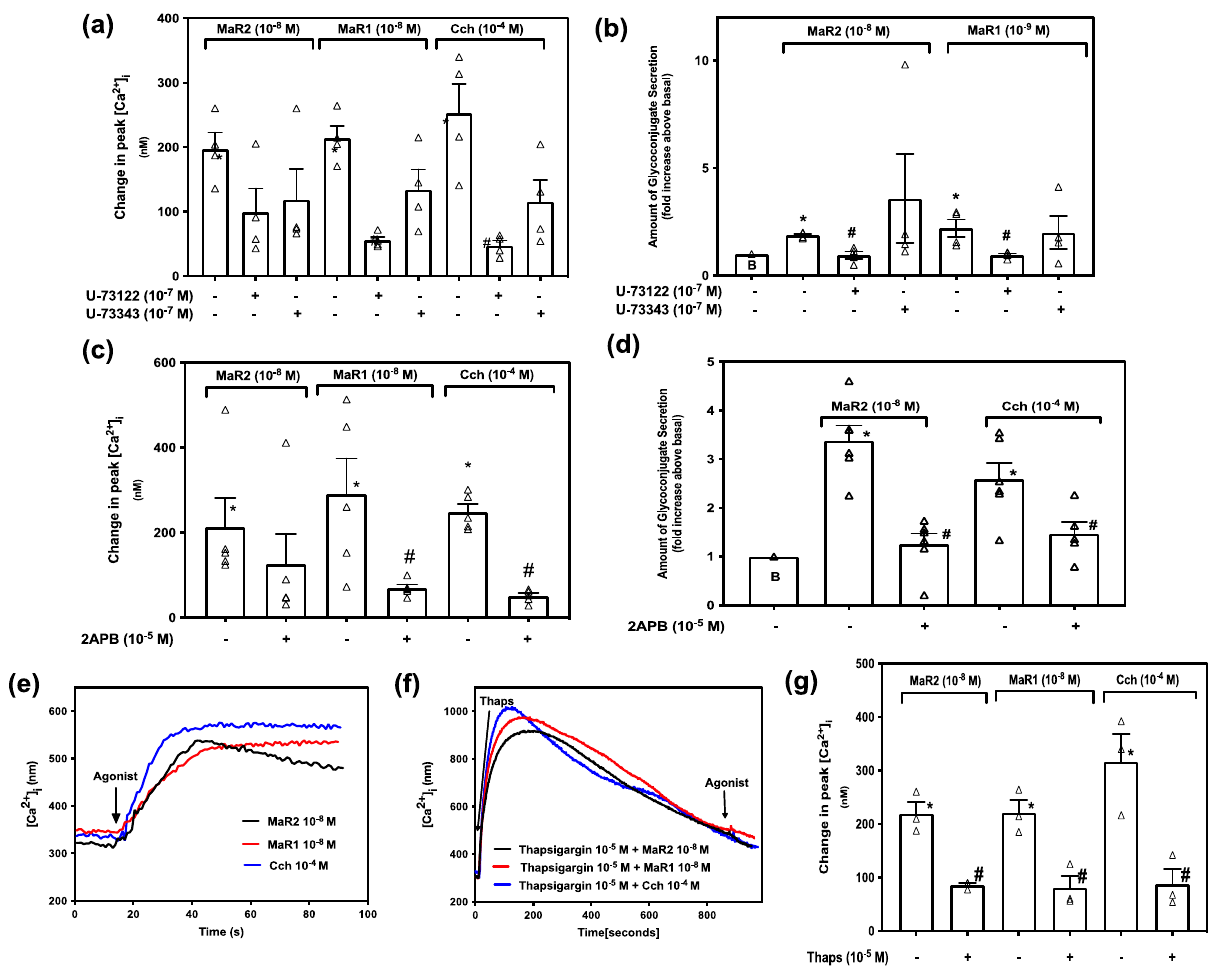
Figure 5. Maresin 2 increase in [ Ca 2+ ] i , but not secretion , is independent of the PLC-pathway in rat conjunctival goblet cells. Goblet cells were treated with vehicle, the active PLC inhibitor U-73122 or the inactive PLC inhibitor U-73343 both at 10 − 7 M for 30 min and stimulated with MaR2 (10 − 8 M), MaR1 (10 − 8 M) or Cch (10 − 4 M). ( a ) shows changes in peak [ Ca 2+ ] i and ( b ) shows glycoconjugate secretion. Goblet cells were treated with vehicle or 2APB (10 − 5 M) and stimulated with MaR2 (10 − 8 M), MaR1 (10 − 8 M) or Cch (10 − 4 M). ( c ) shows changes in peak [ Ca 2+ ] i , and ( d ) shows glycoconjugate secretion. Goblet cells were stimulated with MaR2 (10 − 8 M), MaR1 (10 − 8 M) or Cch (10 − 4 M) alone or incubated with vehicle or thapsigargin (10 − 5 M) for 15 min and then stimulated with MaR2 (10 − 8 M), MaR1 (10 − 8 M) or Cch (10 − 4 M). ( e , f ) show changes in [ Ca 2+ ] i with time, while ( g ) shows changes in peak of [ Ca 2+ ] i . Data are mean ± SEM of four ( a ), four ( b ), five ( c ), six ( d ), and three ( e – g ) experiments. White triangles indicate individual data points. * shows significance above basal. # shows significance between MaR2 and inhibitor then MaR2 or control and inhibitor then control.